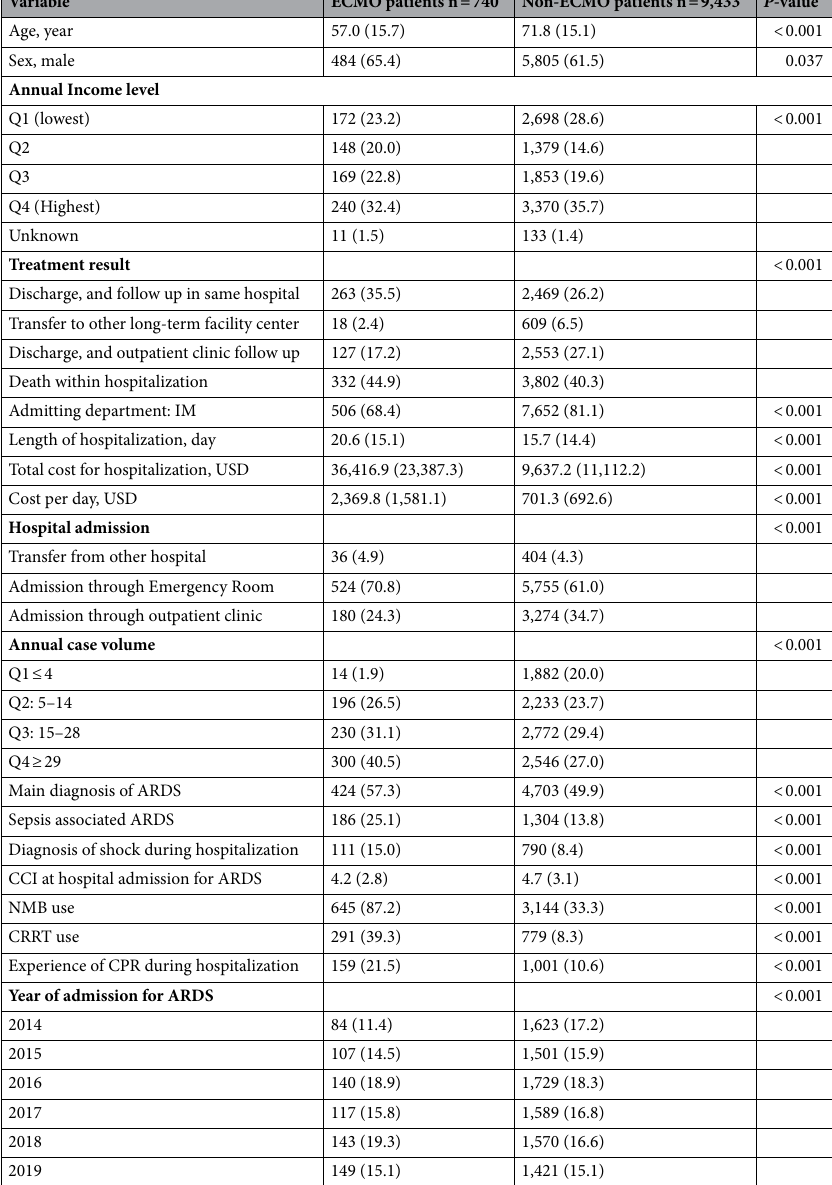
Table 2. Comparison of clinicopathological characteristics between the ECMO and non-ECMO groups among ARDS’ patients. Presented as mean values (standard deviation) for continuous variables and number (%) for categorical variables. ARDS, acute respiratory distress syndrome; ECMO, extracorporeal membrane oxygenation; IM, internal medicine; USD, United States Dollars; NMB, neuromusclar blockade; CRRT, continuous renal replacement therapy, CPR, cardiopulmonary